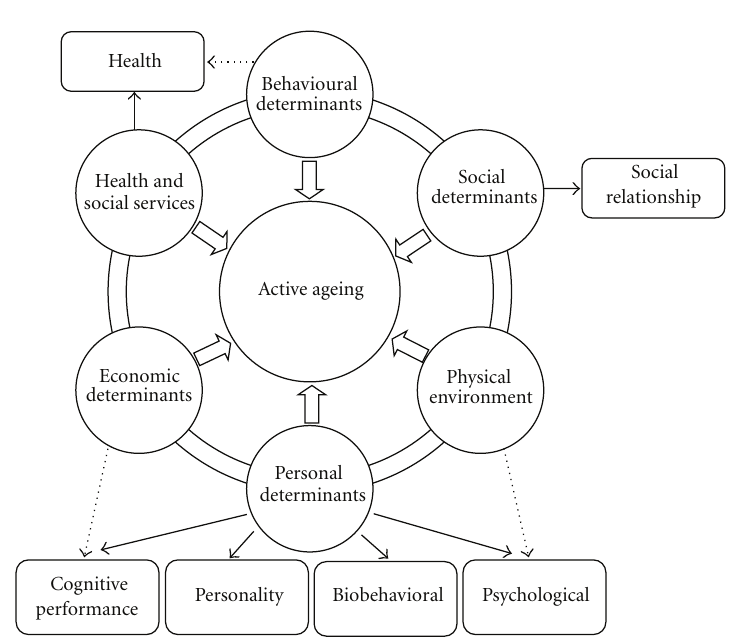
Figure 1: The WHO model and the empirically achieved